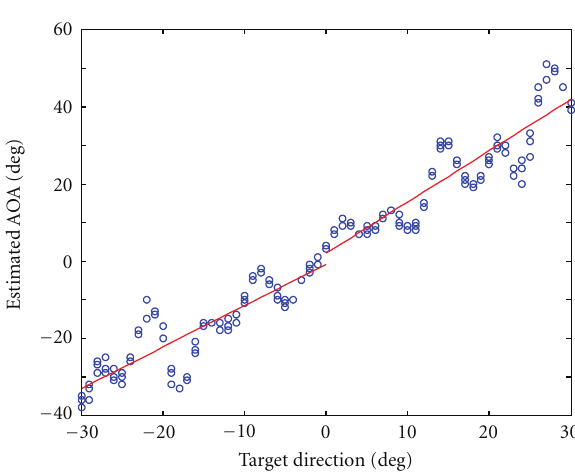
Figure 7: Estimated AOA by MUSIC derived from the measure- ments in anechoic chamber experiments.